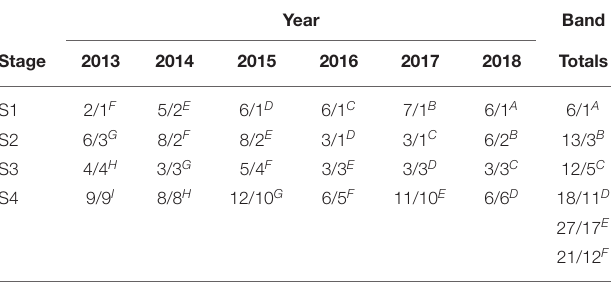
TABLE 4 | Number of trials and environments (presented as trials/environments) in each stage (S1 to S4) and year (2013-2018) in the durum breeding program with data bands indicated as superscripts.